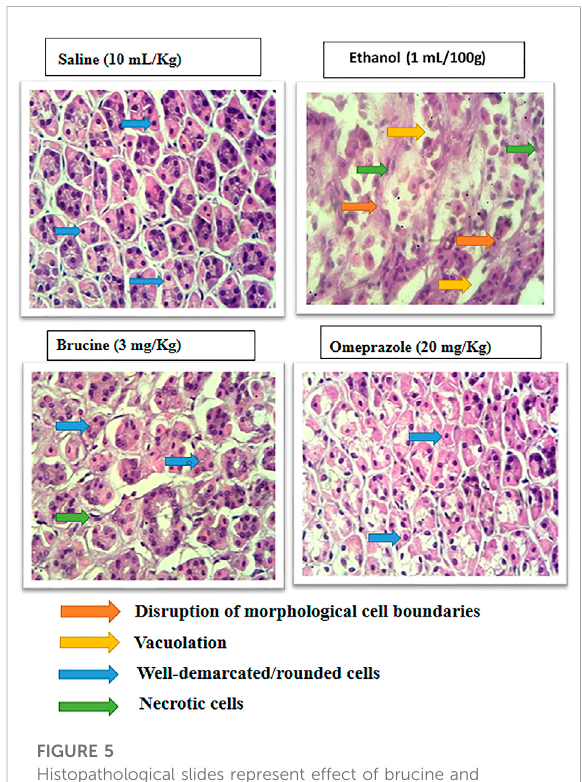
FIGURE 5 Histopathological slides represent effect of brucine and omeprazole in ethanol- induced ulcer rats gastric tissues. Saline group showing normal histological features. Ethanol ulcer group showing marked histopathological deformities by loss of stomach architecture, vacuolization and cloudy swelling. Brucine and omeprazole treatment groups showing near normal architecture with mild to moderate